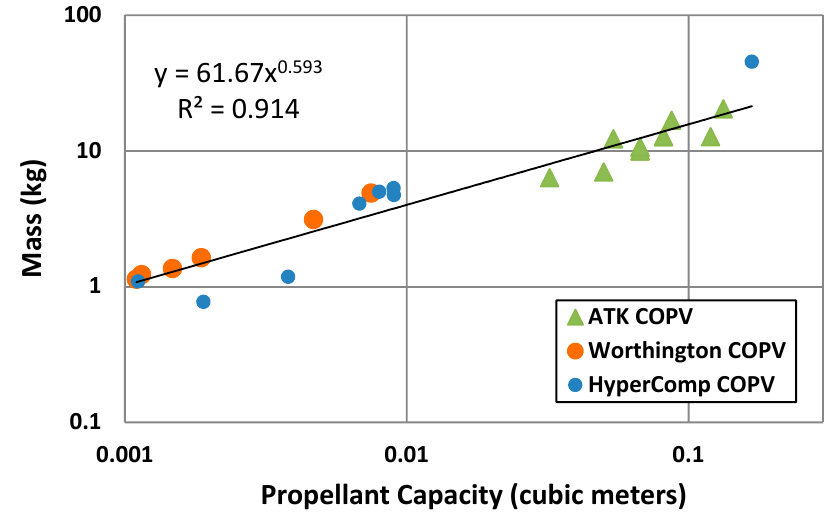
Figure A2. Tank mass vs. tank volume.